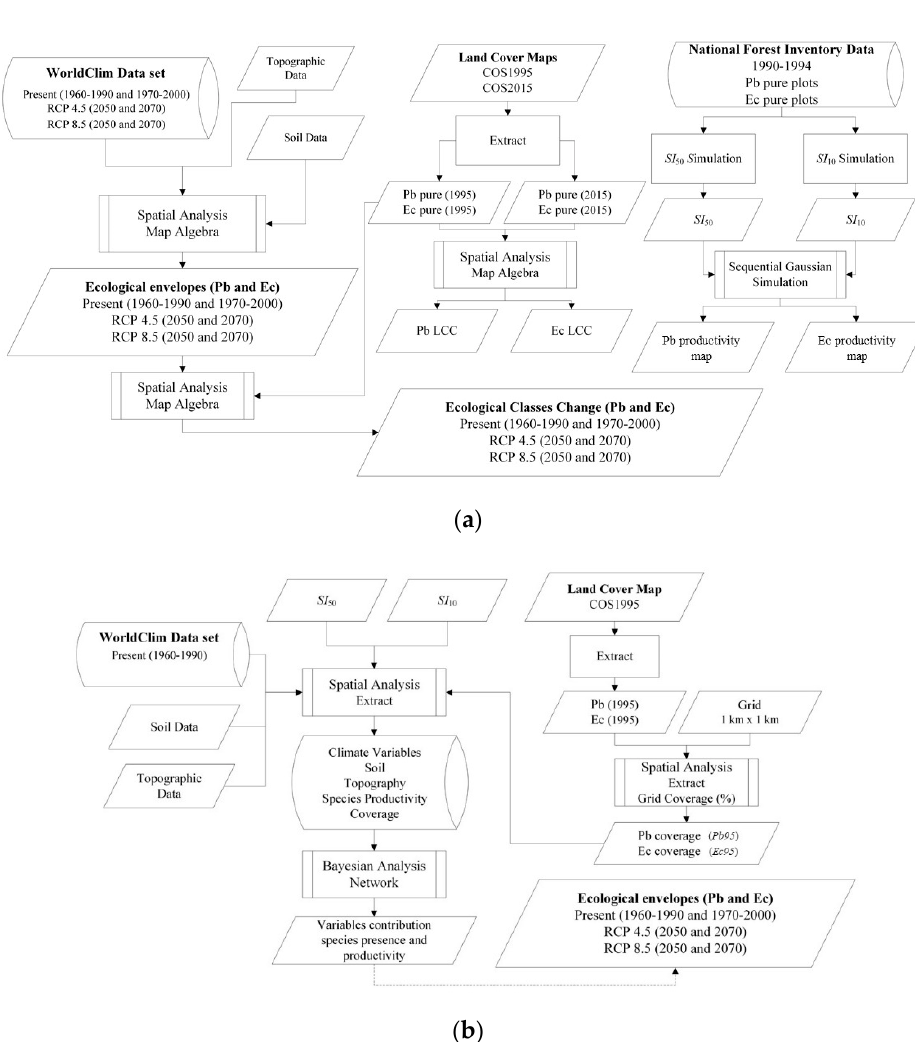
Figure 4. Workflow: ( a ) species ecological envelopes and ecological classes change maps, land cover change maps (Pb LCC and Ec LCC), and productivity maps ( SI 50 and SI 10 ); ( b ) Bayesian network analysis for species presence ( Pb95 and Ec95 ) and productivity ( SI 50 and SI 10 ).